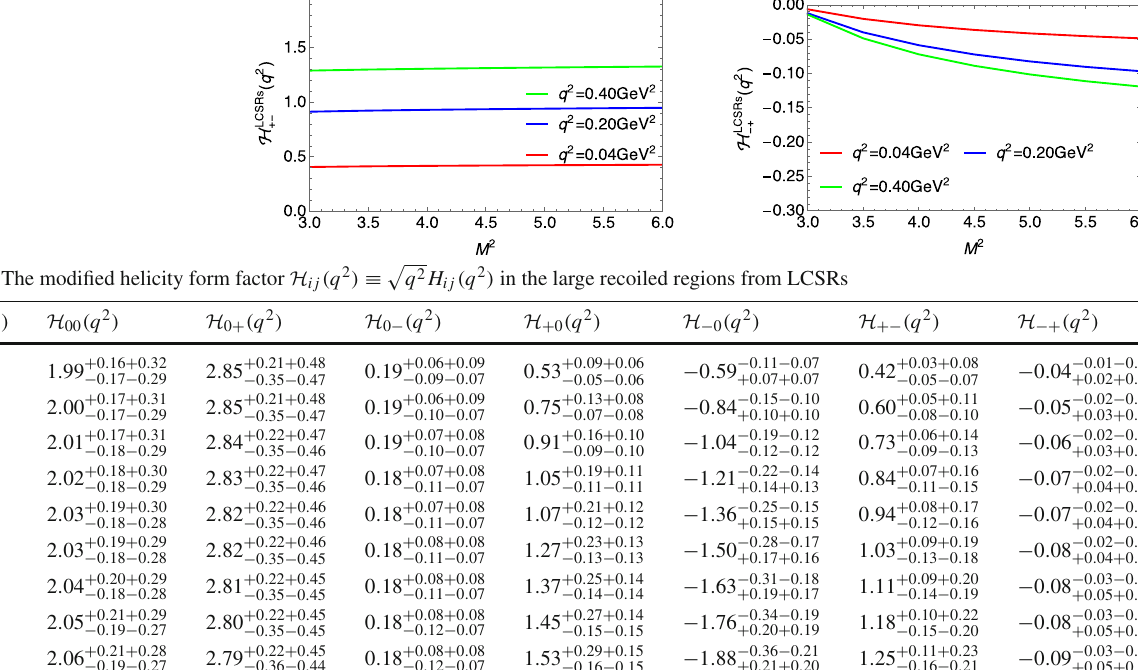
Table 2 The modified helicity form factor H ij ( q 2 ) ≡